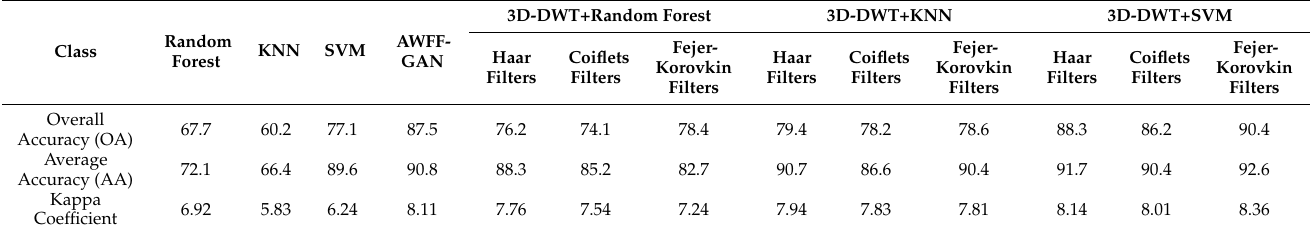
Table 3. OA, AA and kappa coefficient of entire class with different algorithms for Indian Pines hyperspectral data.